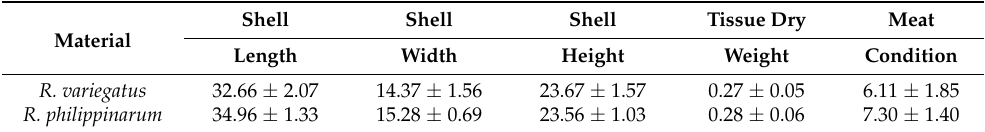
Figure 2. Comparison of the external radial ribs and degree of separation of the incurrent and excurrent siphons of ( a , c ) Ruditapes variegatus and ( b , d ) R. philippinarum . Table 1. Comparison of phenotype traits between Ruditapes philippinarum ( n = 30) and R. variegatus ( n = 30), made from specimens collected on the south coast of